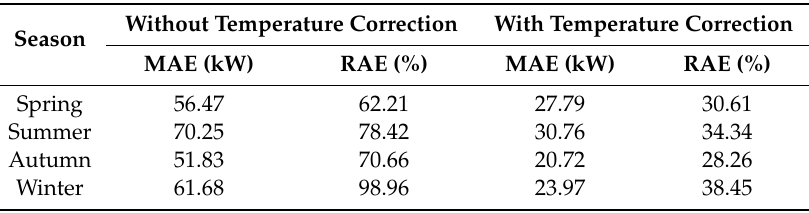
Table 3. Accuracy comparison of PV output